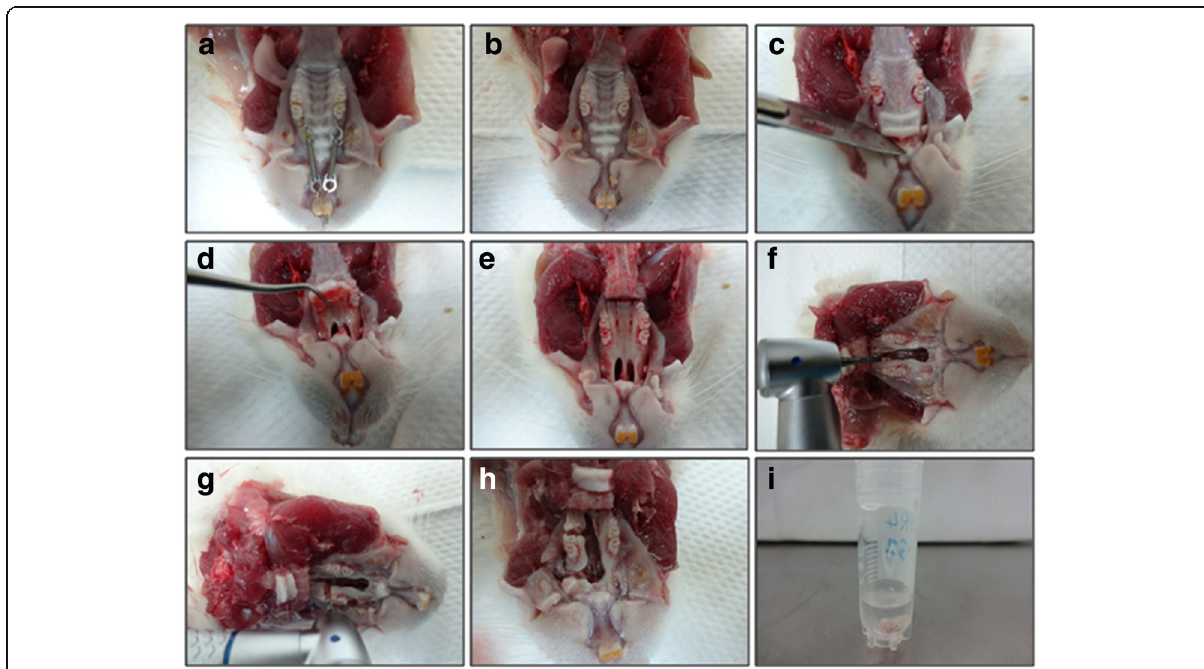
Fig. 3 Procedure of tissue dissection. a Maxilla detached from mandible. b Orthodontic appliance removed. c Cutting gingiva. d , e Gingival detachment. f , g , h Cutting the area of interest. i Preserving tissue specimens